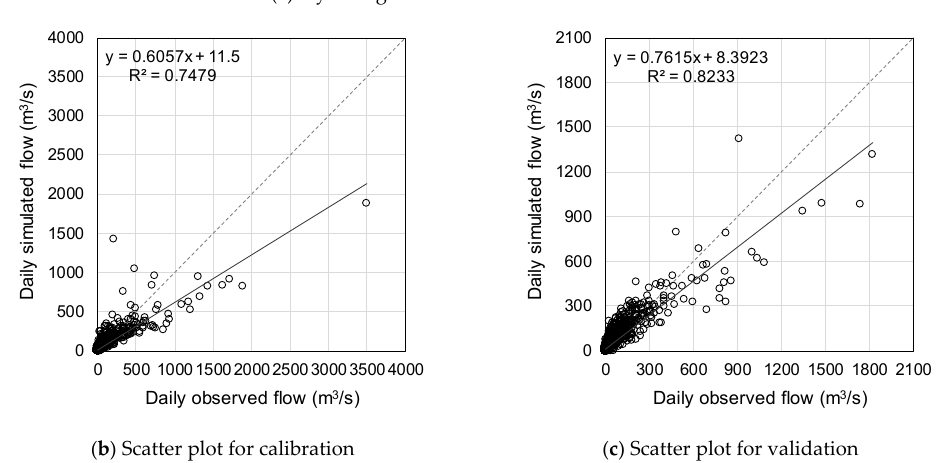
Figure 3. Result of the HSPF model calibration and validation over Andong dam watershed.